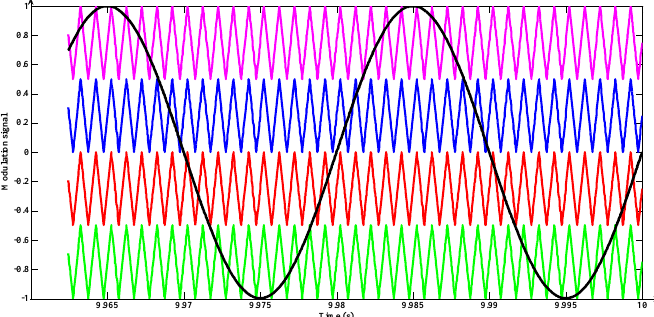
Figure 35. Waveform for phase disposition.